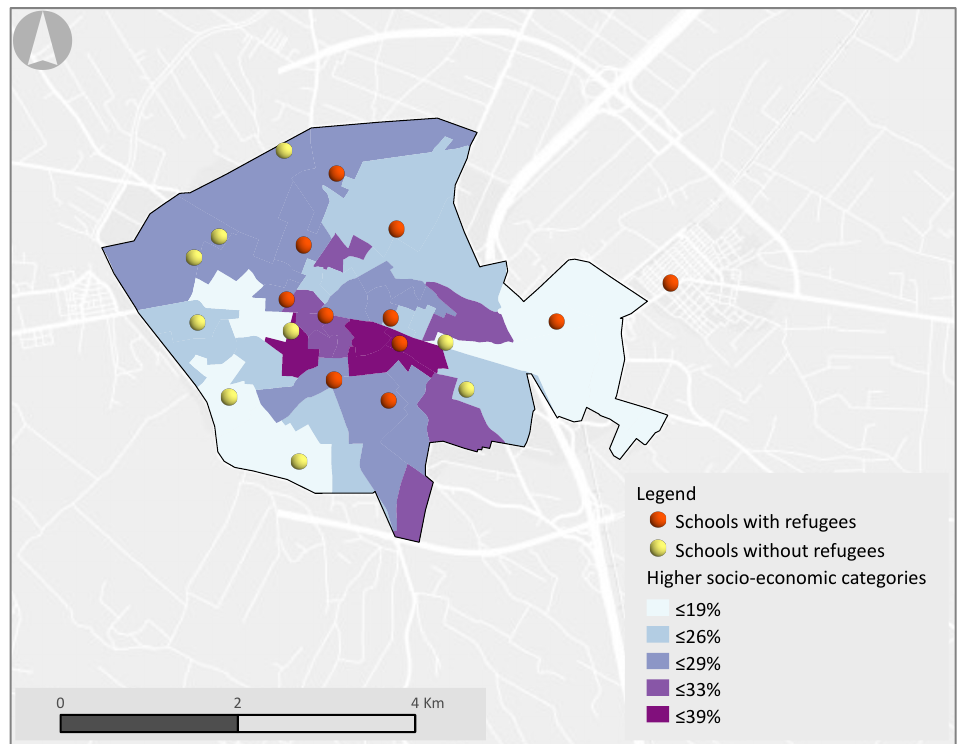
Figure 6. Distribution of higher socio-economic categories (2011) and refugee school population in Katerini. Source: Authors’ elaboration and EKKE–ELSTAT